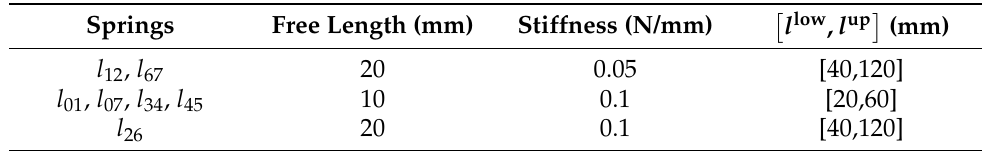
Table 1. Free length and axial stiffness of springs